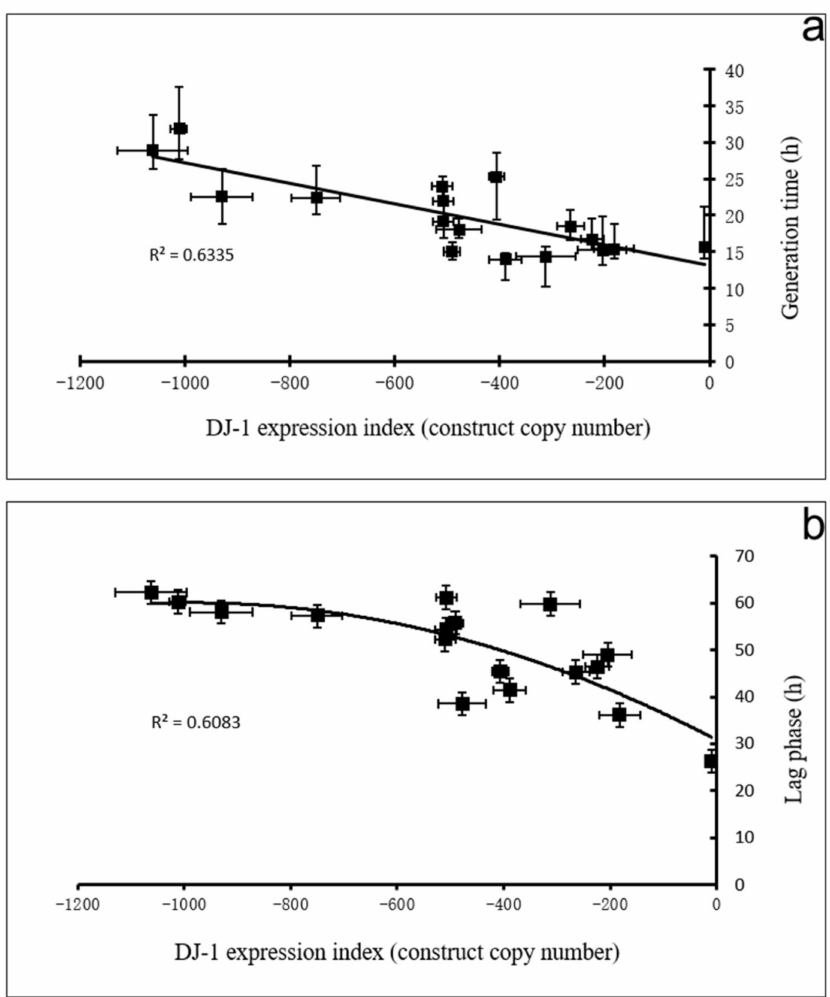
Figure 6. DJ-1 knockdown dramatically inhibits growth in oxidatively stressed cells. ( a ): The generation time of DA transformants grown in liquid media under oxidative stress (450 µ M H 2 O 2 ) increased with increasing DJ-1 antisense inhibition copy numbers. R 2 represents the fraction of the variance that was attributable to the regression relationship. The regression was highly significant at p = 1.8 × 10 − 4 (F test, n = 16). Error bars for the generation times indicate averages for the 95% confidence limits from 3 independent experiments. Error bars for the copy numbers are standard errors from 3 independent experiments. ( b ): The lag time of DA transformants under oxidative stress increases (450 µ M H 2 O 2 ) with increasing DJ-1 antisense inhibition copy number. R 2 represents the fraction of the variance that was attributable to the regression relationship. The regression was highly significant at p = 1.7 × 10 − 4 (F test, n = 16). Error bars are standard errors from 3 independent experiments. Lines were fitted by least squares. R 2 indicates the fraction of the variance explained by the